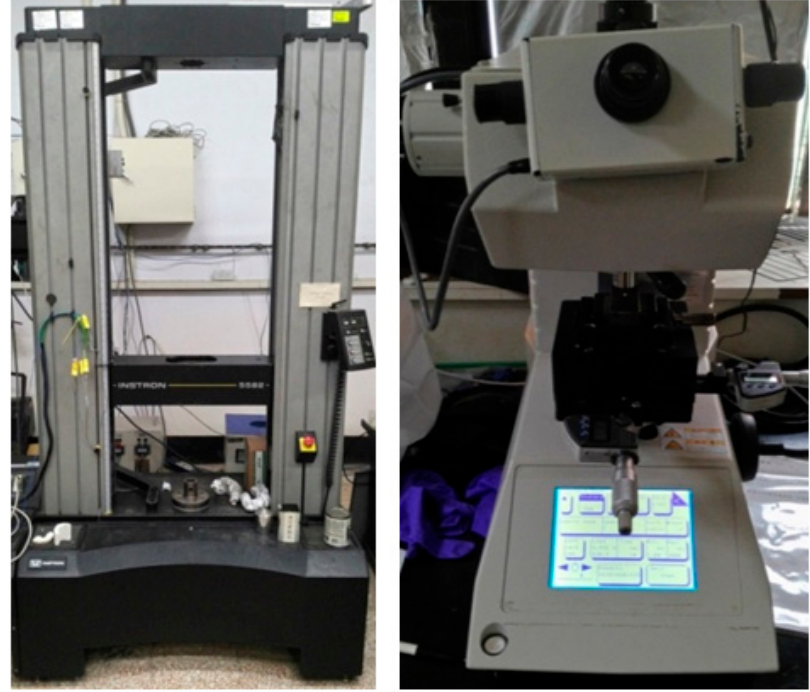
Figure 6. Dynamic testing machine Bose 3510.